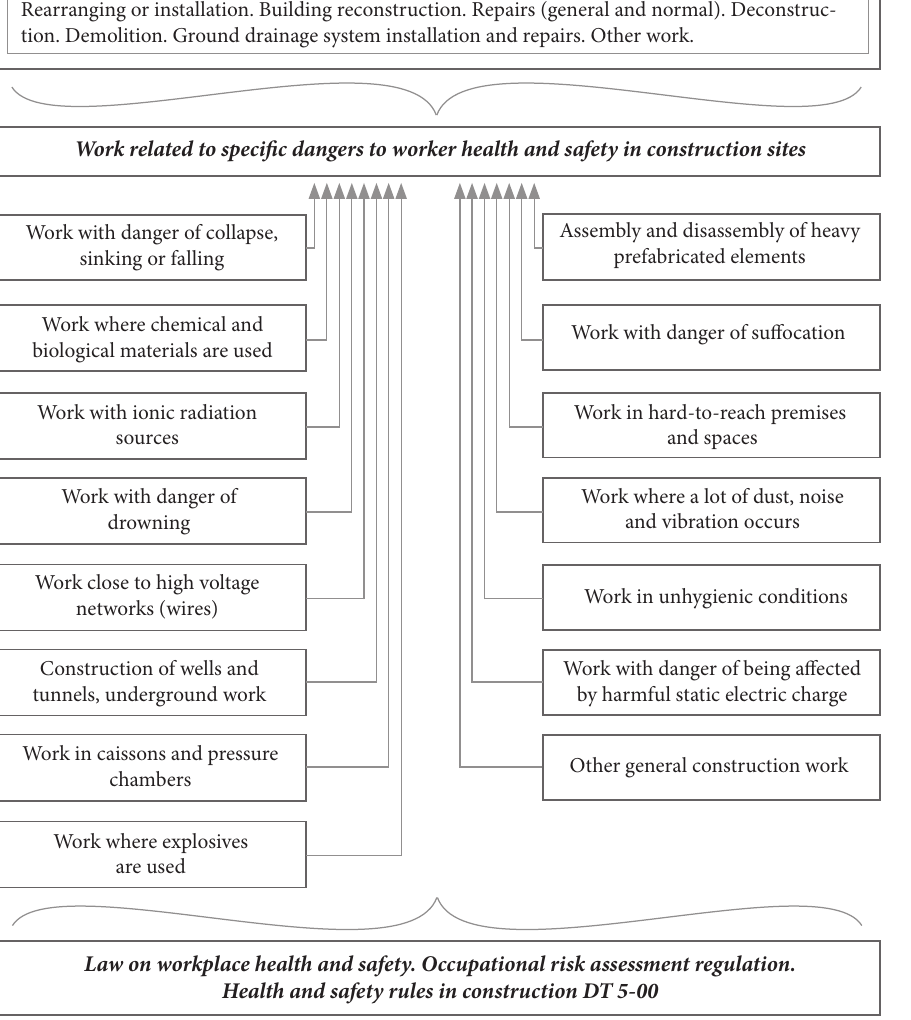
Fig. 1. Potential dangers when working at construction sites and their legal